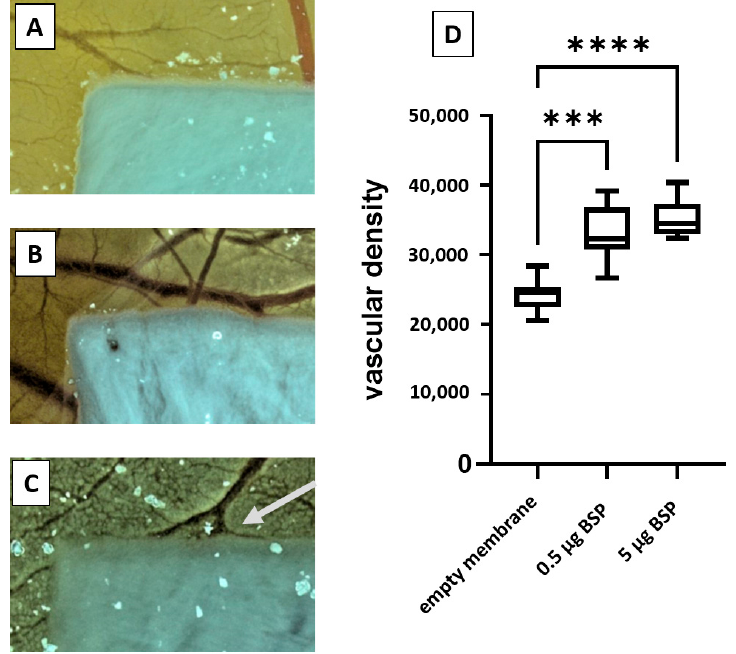
Figure 5. Yolk sac membrane assay. Collagen membrane without BSP ( A ), with 0.5 μ g BSP ( B ) or 5 μ g BSP ( C ) 72 h after putting the membrane onto the yolk sac membrane. ( D )—Quantitative analyses of vascular density. (*** p < 0.005; **** p < 0.001).